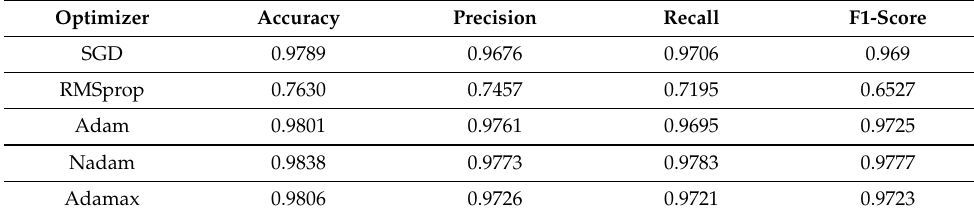
Table 7. A detailed comparison of optimizers for multi-class sub-category